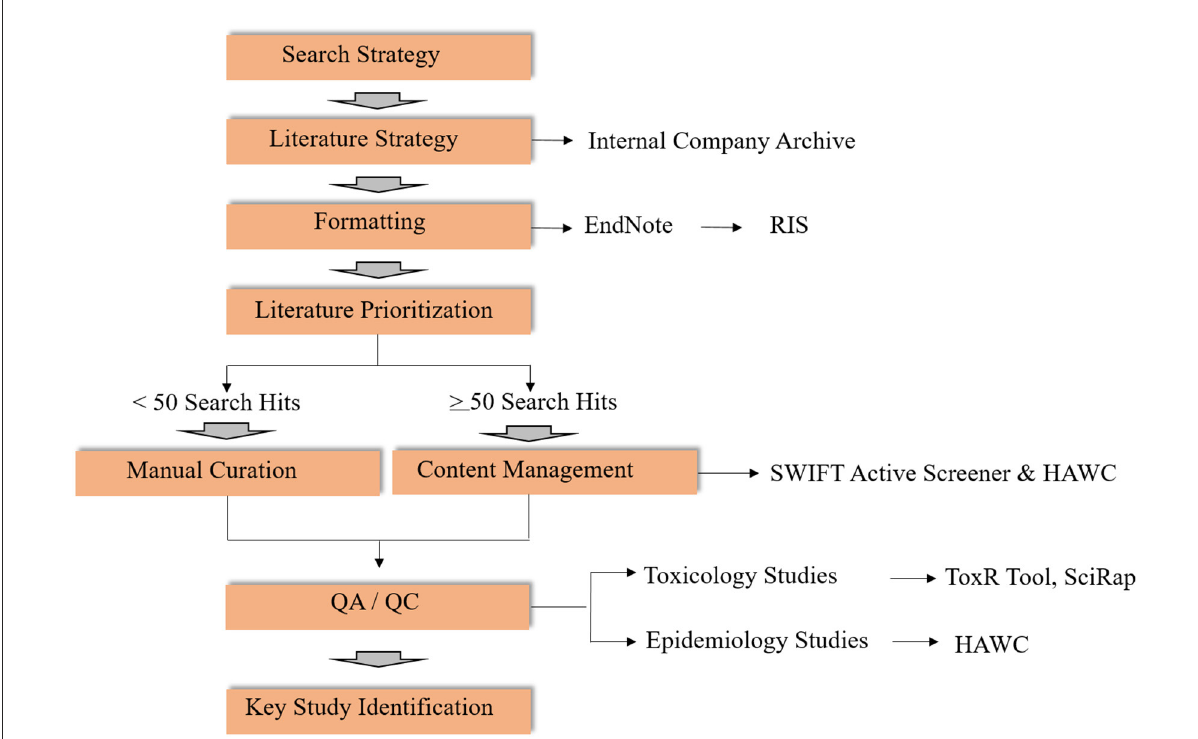
FIGURE2 Workflow for literature review for activities related to OELs (RIS, Research Information Systems; SWIFT, Sciome Workbench for Interactive computer-Facilitated Text-mining; HAWC, Health Assessment Workspace Collaborative; SciRap, Science in Risk Assessment and Policy; QA/QC, Quality Assessment/Quality